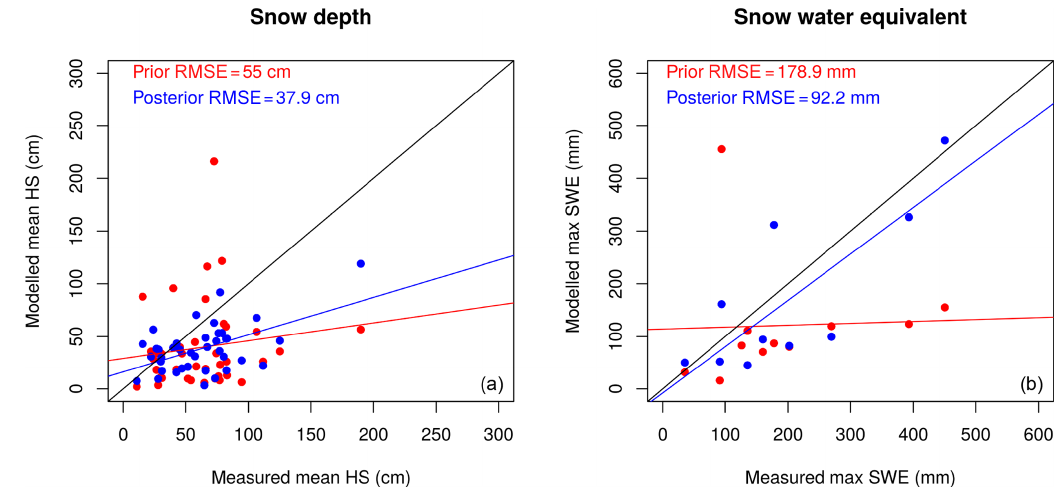
Figure 5. Simulated snow depth at the IMIS stations (HS) and snow water equivalent at the GCOS stations (SWE) for both the prior (red) and posterior median (blue) compared to the observation mean. The mean is computed from all values over the entire WY2016. The posterior estimate is markedly improved in both variables. Regression lines compare the fit of the posterior and prior estimates with respect to observations against the 1:1